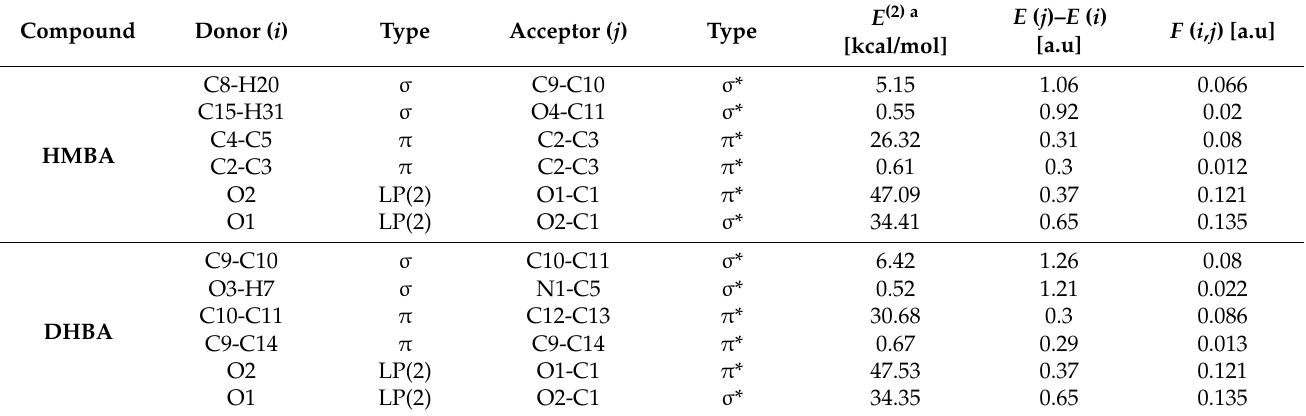
Table 2. Natural bond orbital (NBO) analysis of HMBA and DHBA